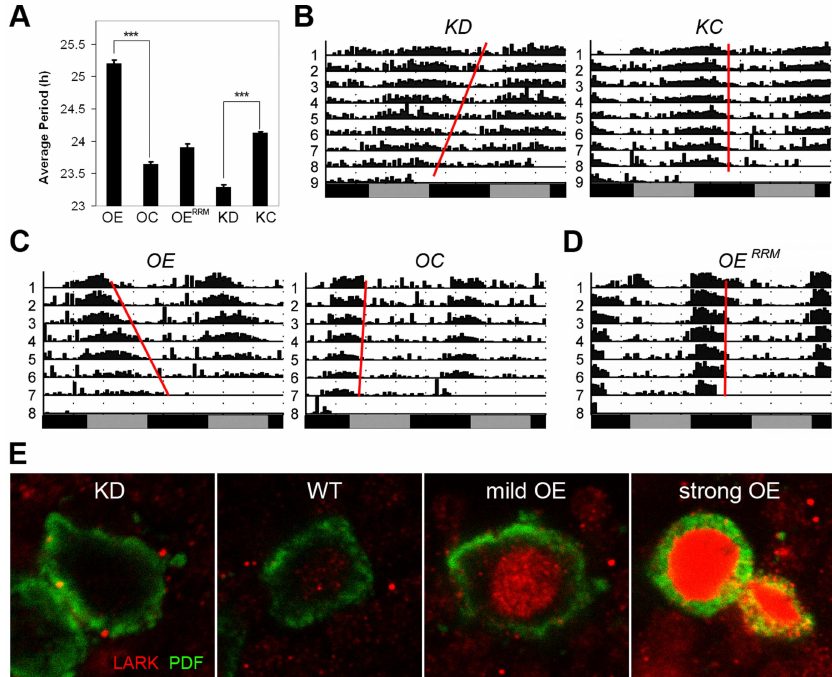
Figure 5. Altered LARK expression in PDF neurons affect circadian period. A, Average period length for various genotypes (n=192, 144, 64, 130 and 166 for OE, OC, OE RRM , KD, and KC, respectively). Error bars represent SEM. *** p , 10 2 56 between OE and OC; P , 10 2 57 between KD and KC (Student’s t-test). B–D, Representative activity plots for various genotypes. E, Immunohistochemistry showing LARK in the PDF neurons of various genotypes. KD, knockdown of LARK in PDF neurons, genotype: w 1118 ; pdf-gal4 uas-dicer2/ + ; lark 1 uas-lark RNAi / + . KC, control line for the knock-down, genotype: w 1118 ; pdf-gal4 uas-dicer2/ + . OE, moderate overexpression of LARK in PDF neurons, genotype: w 1118 ; pdf-gal4/ + ; Tub-gal80 ts uas-lark/ + . OC, control for the overexpression, genotype: w 1118 ; pdf-gal4/ + ; Tub-gal80 ts / + . OE RRM , Overexpression of a mutant form of LARK with defective RRM domains, genotype: w 1118 ; pdf-gal4/uas-lark RRM .